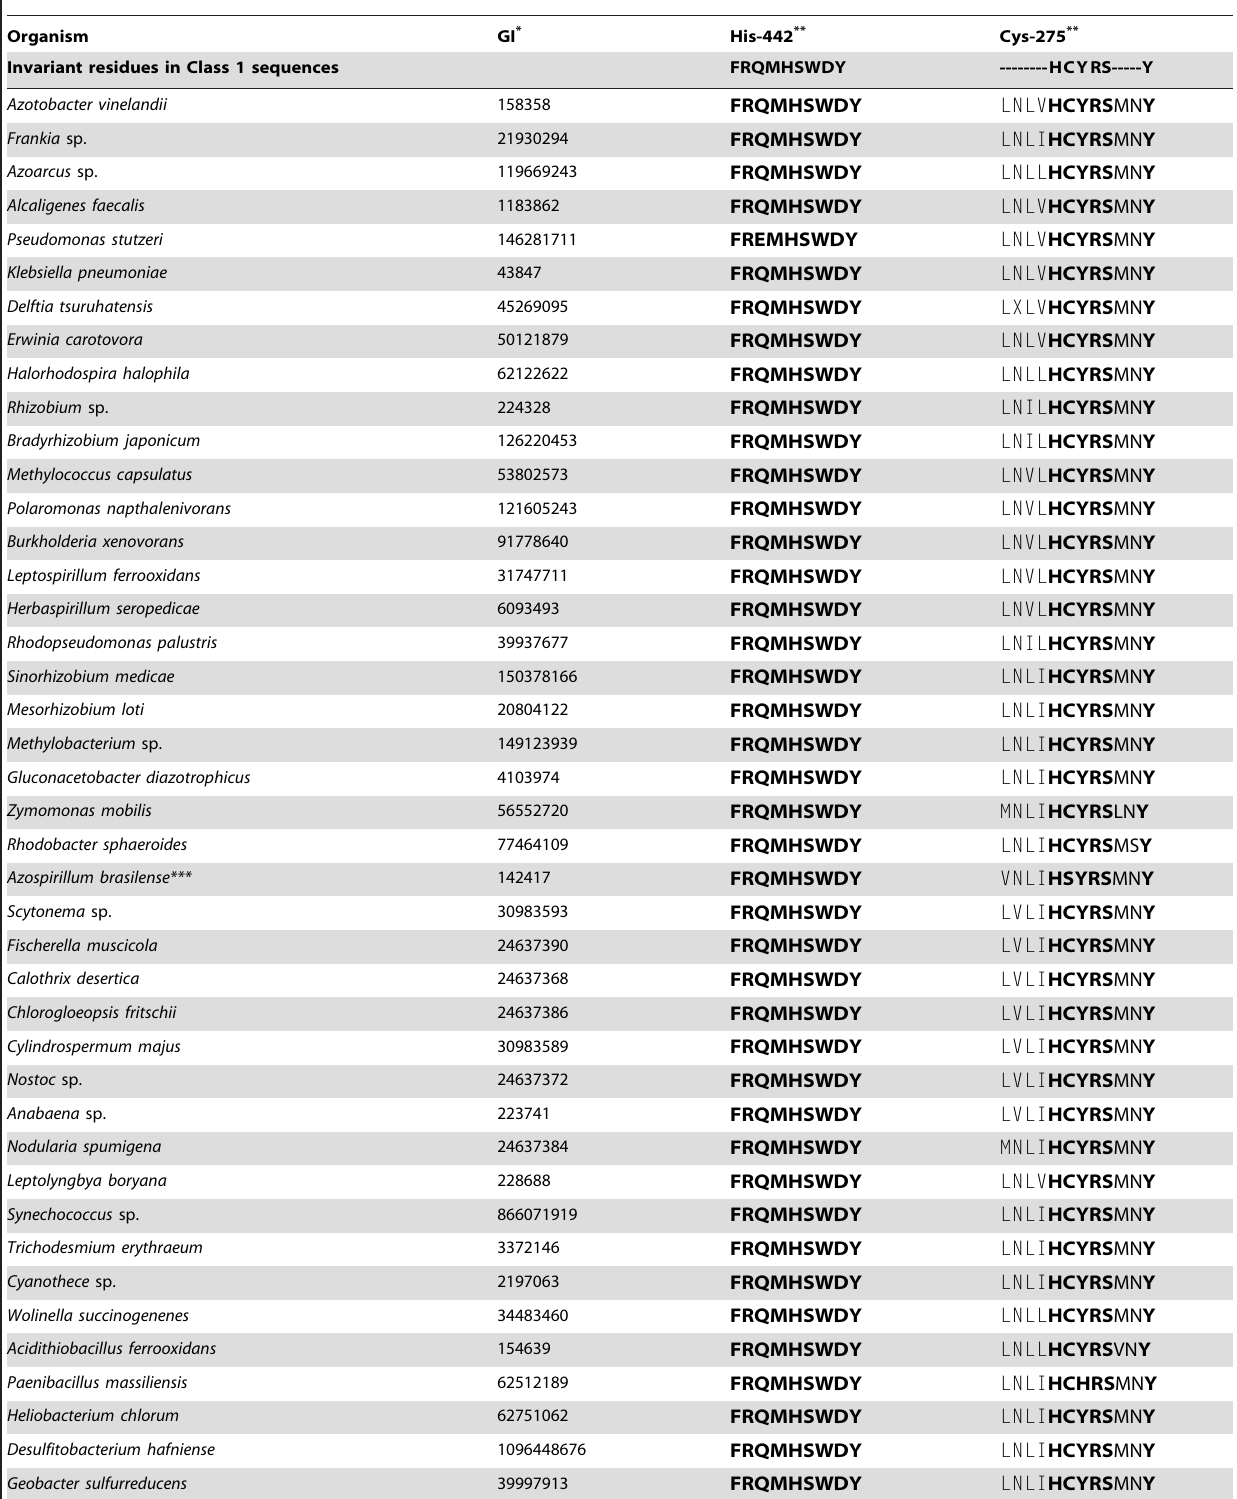
Table 1. Group I NifD sequences surrounding the His and Cys residues that attach the MoFe cofactor to the protein.